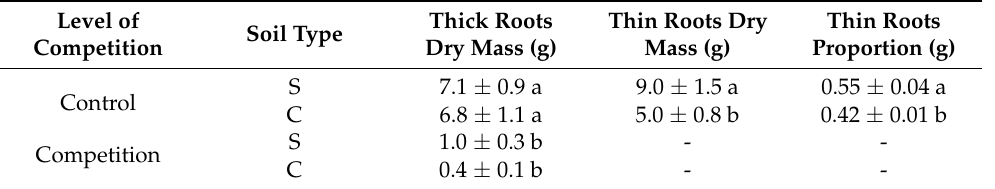
Table 2. Effect of level of competition and soil type (loamy sand and clay) on thick roots, thin roots and thin roots proportion of LANZA ®